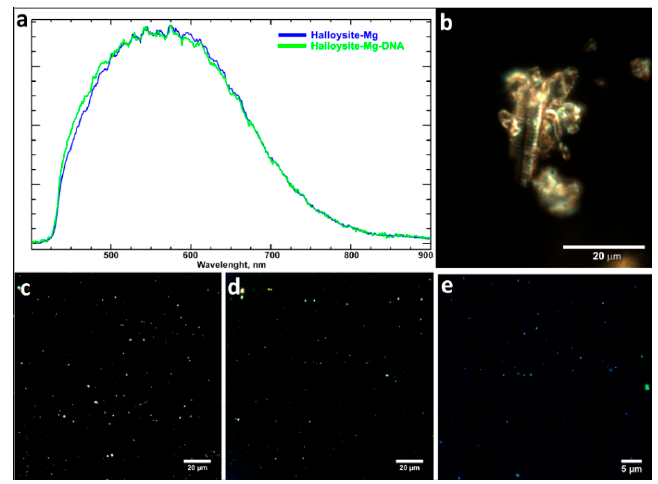
Figure 6. Averaged spectral profiles collected from halloysite-Mg (blue) and halloysite-Mg-DNA (green) particles ( a ), dark-field images of partially dissolved DNA ( b ), halloysite-Mg ( c ), halloysite-Mg-usDNA ( d ) particles and hyperspectral mapping of halloysite-Mg-DNA particles ( e